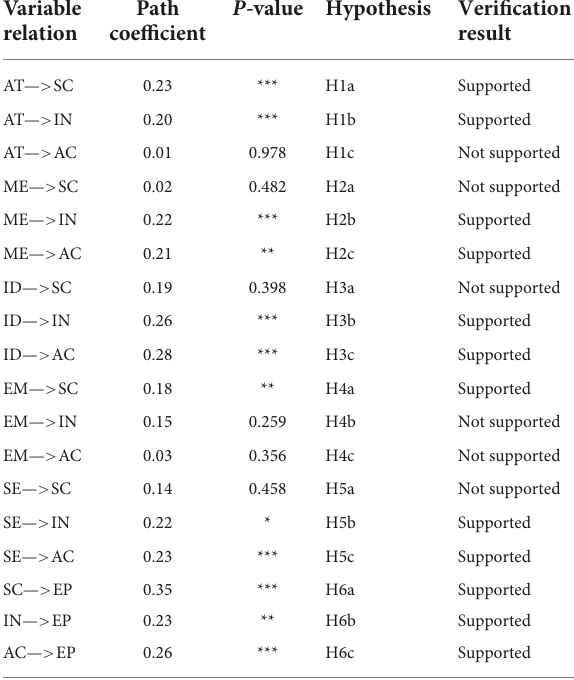
TABLE 2 Hypothesis test